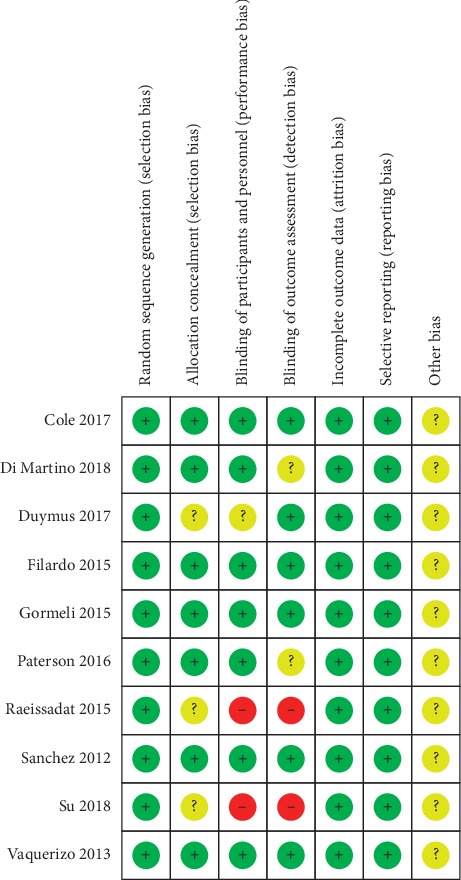
Risk of bias summary: +, low risk of bias; −, high risk of bias; ?, bias unclear.